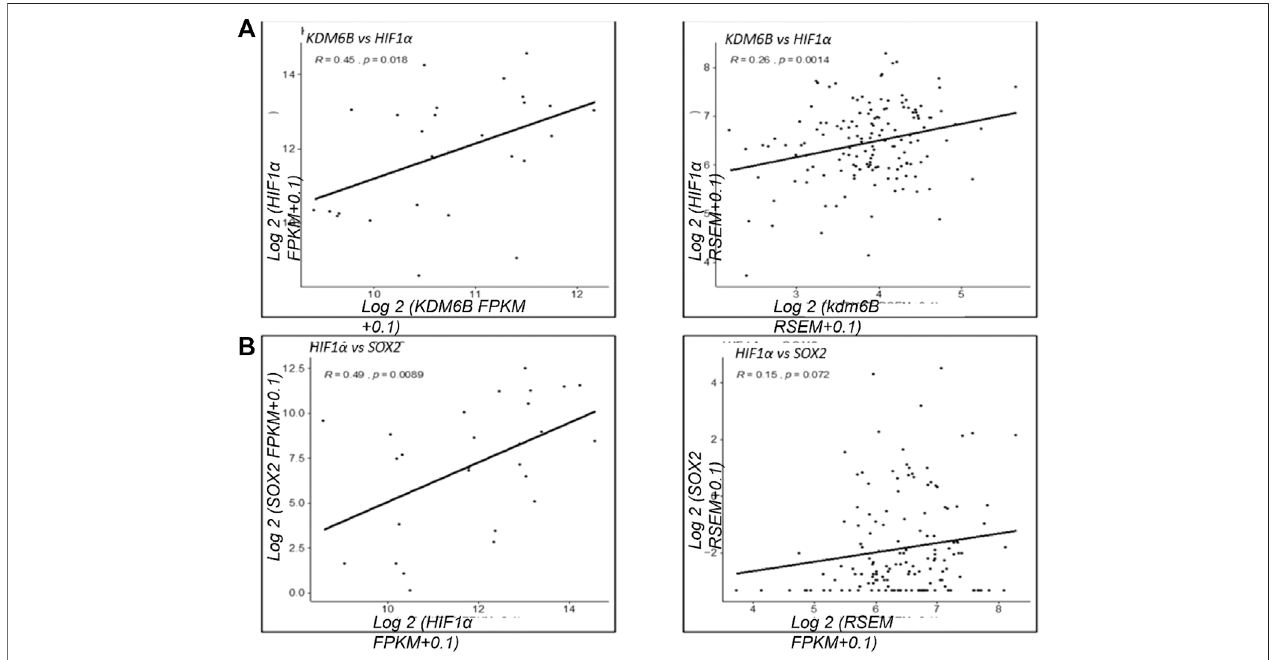
FIGURE 6 | Clinical correlation of KDM6B and HIF 1 α in various cancer types. Correlation analysis of the gene expression between KDM6B and HIF 1 α from metastatic samples. (A) Gene expression in metastatic melanoma samples. (B) Gene expression in metastatic breast samples ** p .value > 0.001, * p .value > 0.01, *** p .value >